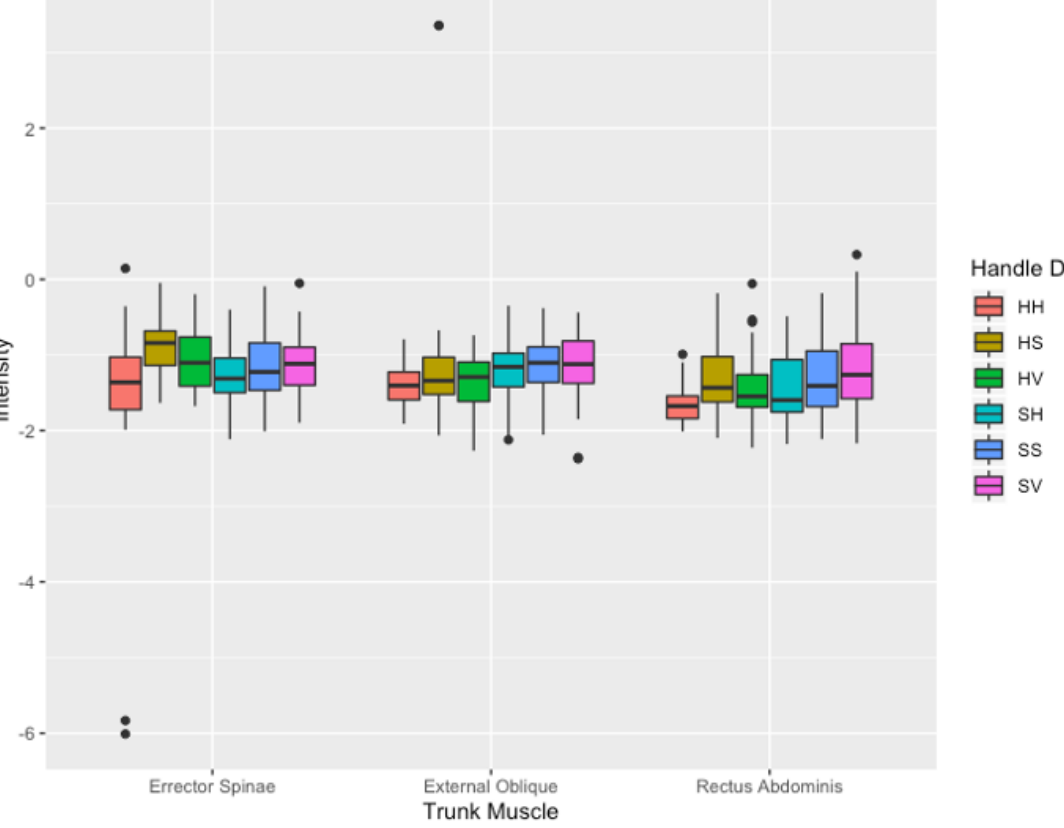
Figure 6. Intensity (mean ± SD) values of the three trunk muscles between handle designs at the initiation of the push. Outliers are noted as black dots. Intensity values are shown as arbitrary units (a.u.).